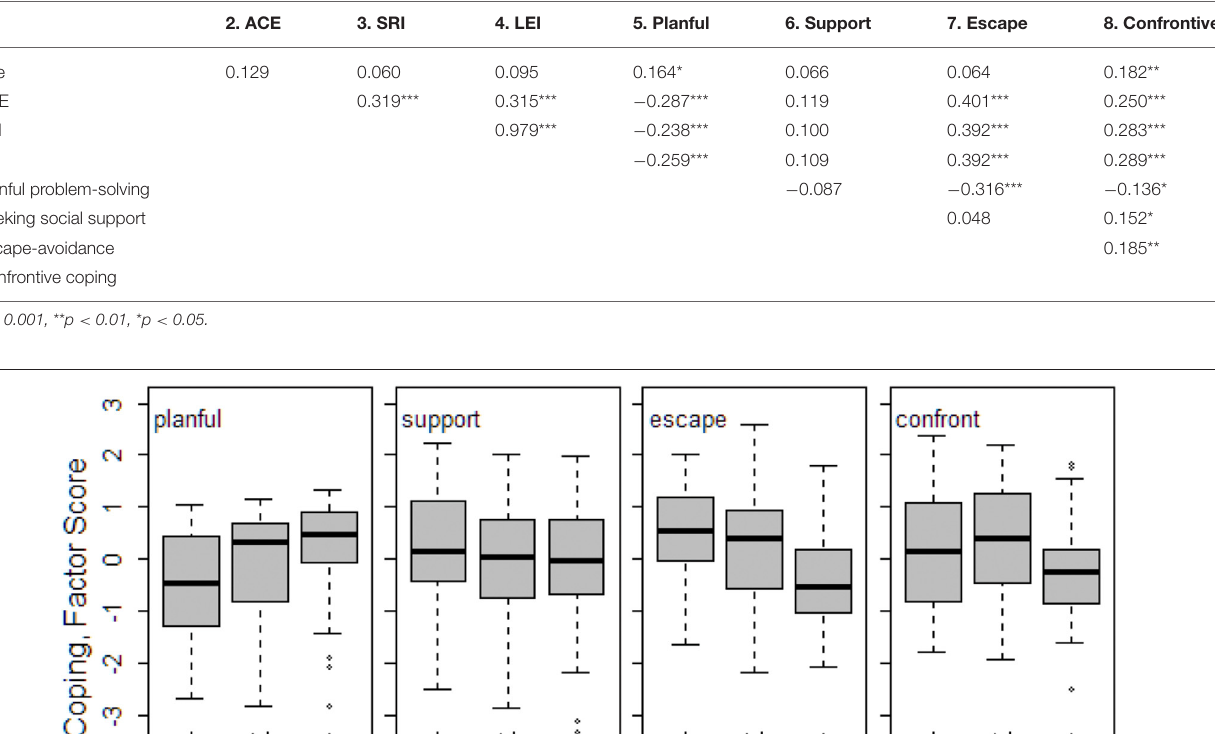
TABLE 2 | Correlations between age, life events, and coping strategies (Pearson’s R ).